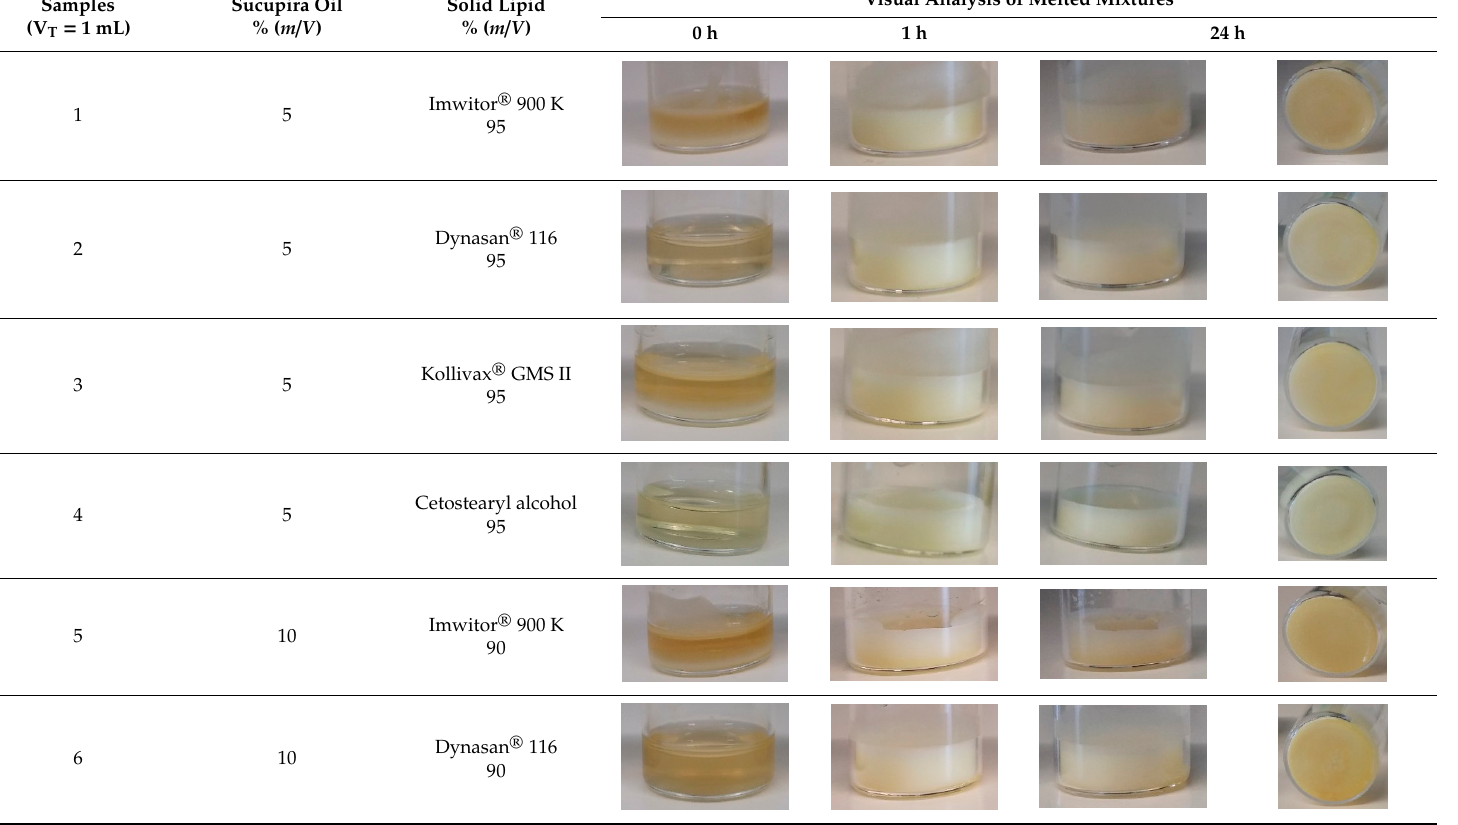
Table 4. Composition of lipid screening samples that demonstrated no macroscopic phase separation, at 0 h, 1 h, and 24 h after their production. Samples